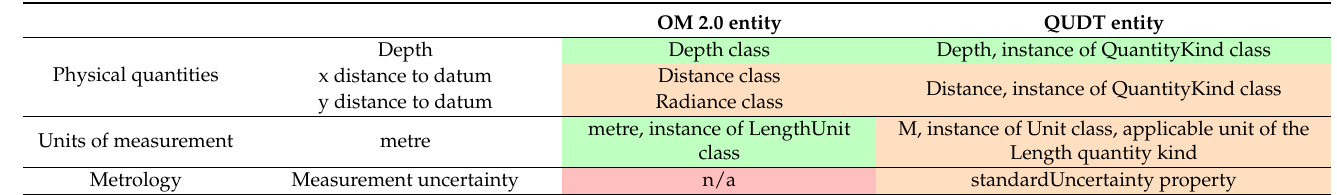
Table 2. Summary of metrology-relevant features implemented for the bathymetry case study using OM 2.0 and QUDT. Colour denotes how well a concept is defined in the ontology (green: fully, amber: partially, red: